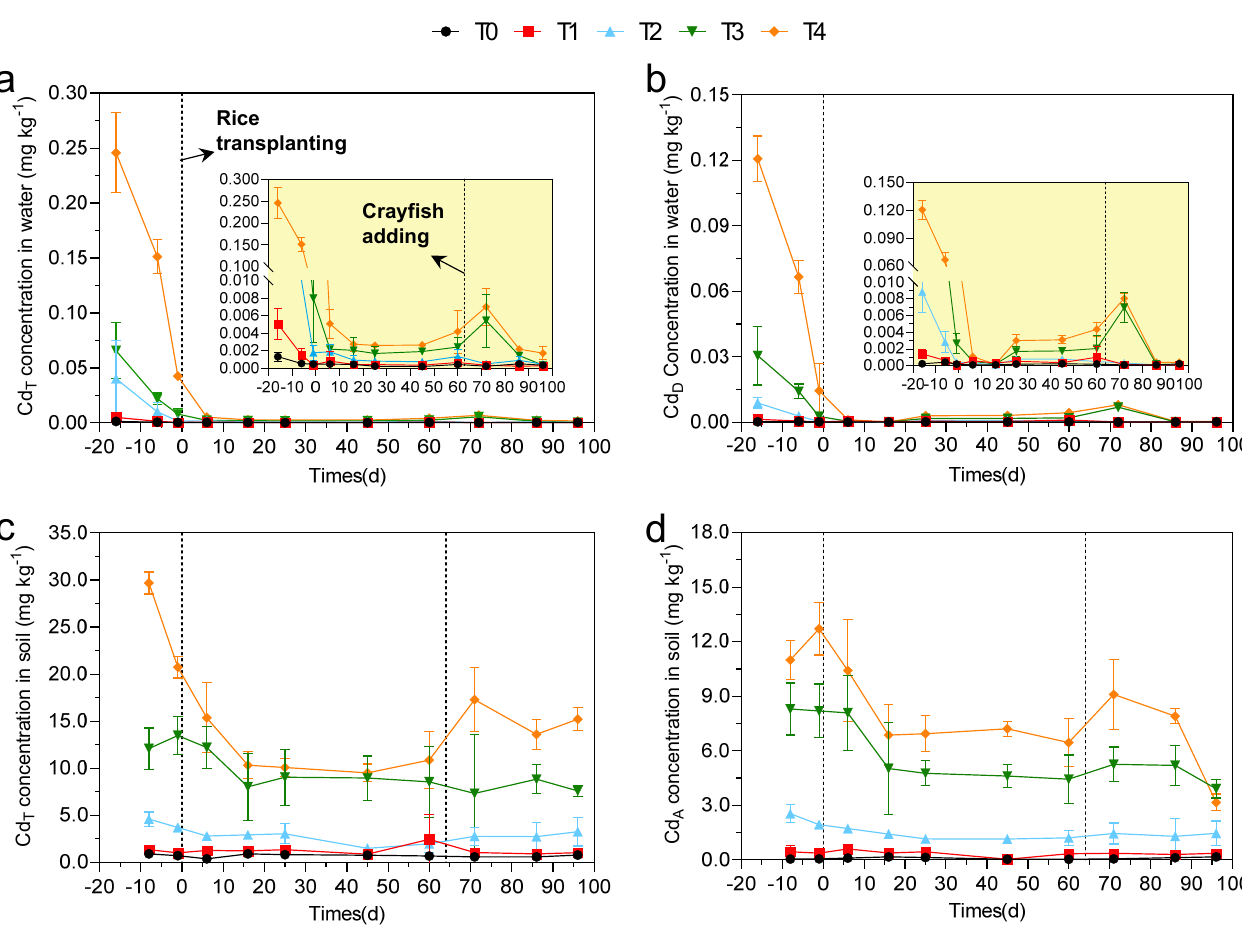
Figure 2. Dynamic changes of Cd in water and soil: ( a ) total Cd (Cd T ) in water; ( b ) dissolved Cd (Cd D ) in water; ( c ) total Cd (Cd T ) in soil; ( d ) available Cd (Cd A ) in soil. The X-axis represents the experimental schedule.